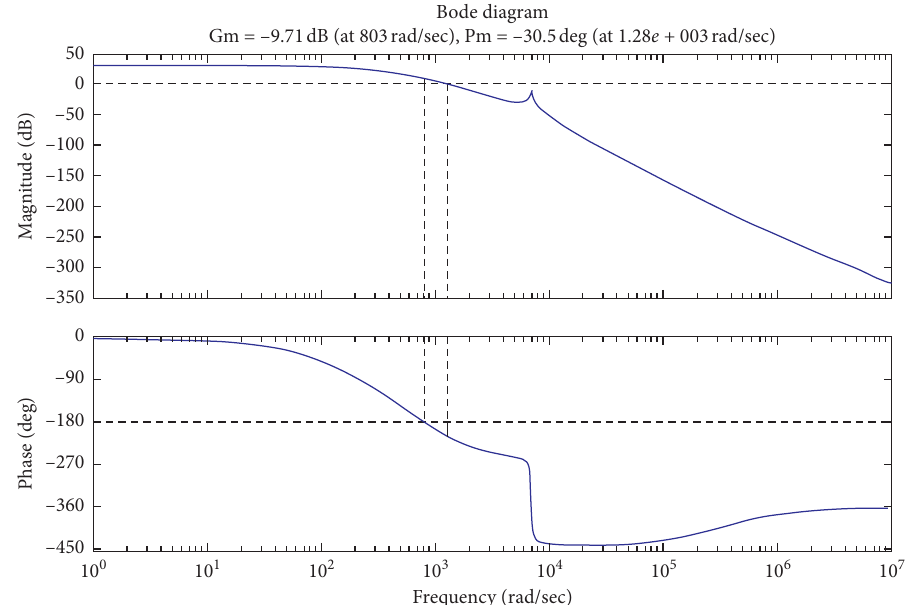
Figure 12: The Bode diagram of the EHSLS before optimization.